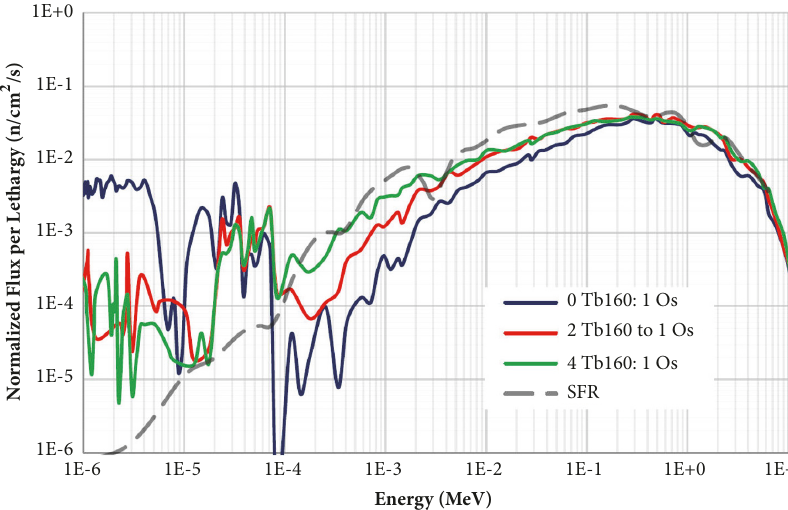
Figure 19: Effect on the neutron spectrum of a neutron screens with different Os and 160 Tb combinations.